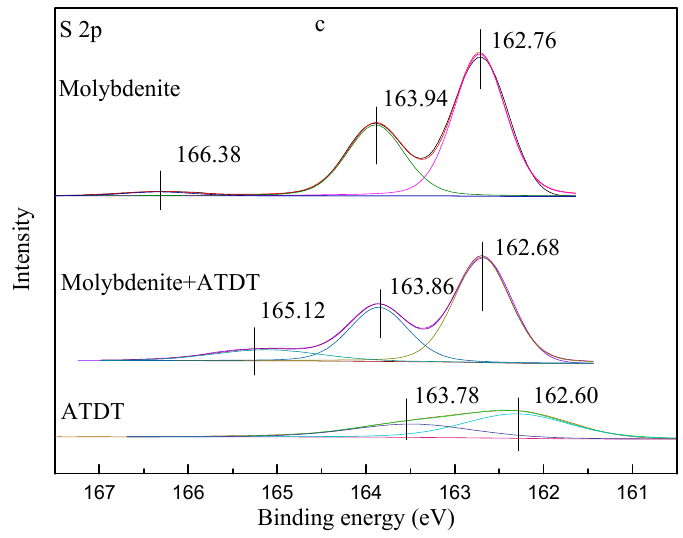
Figure 9. S 2p spectrum of ( a ) the ATDT, ATDT-Cu 2+ complexes; ( b ) the chalcopyrite before and after treatment; and ( c ) the ATDT, molybdenite before and after treatment.